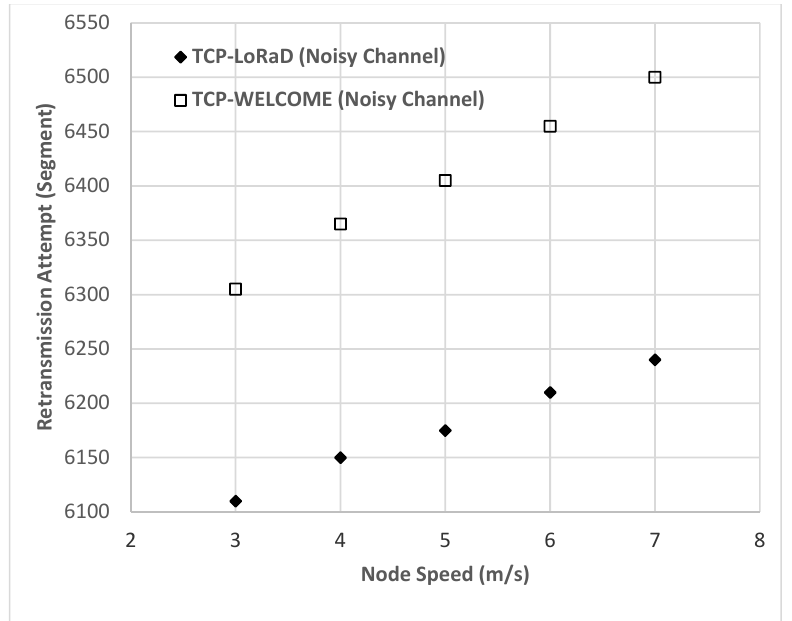
Figure 12. Retransmission Attempt versus node speed in a noisy channel. Comparison of TCP-LoRaD and TCP-WELCOME.